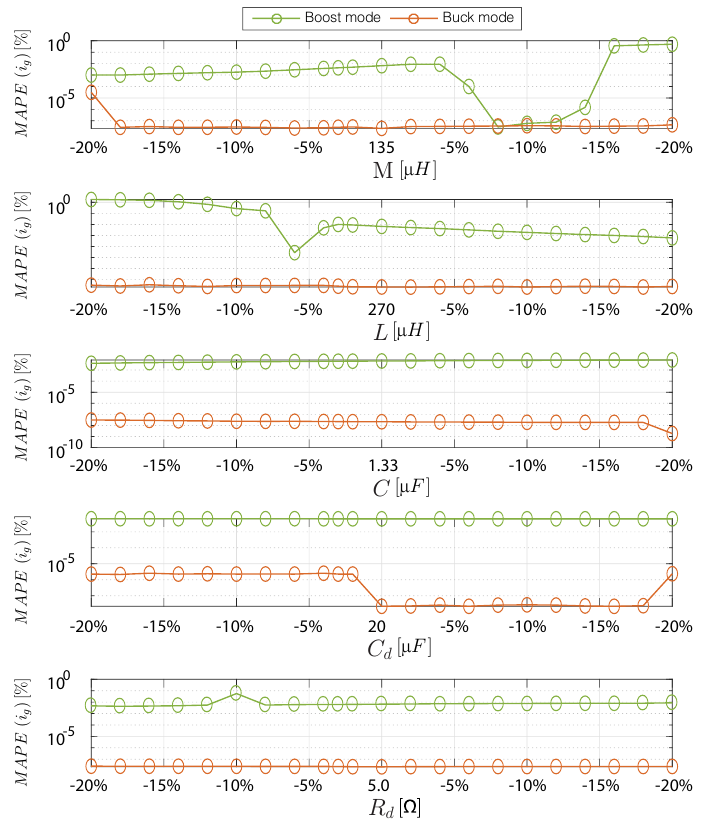
Figure 10. Sensitivity analysis of the predictive inner current loop under converter parameters variations ( M , L , C , C d and R d ) operating in boost mode ( V g = 200 V and V o = 400 V) and buck mode ( V g = 400 V and V o = 200 V) both with a i ref = 6